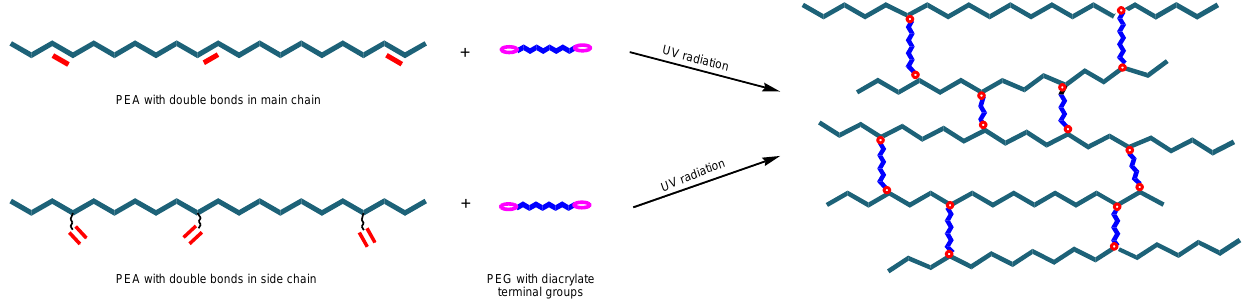
PEA with double bonds in side chain PEG with diacrylate